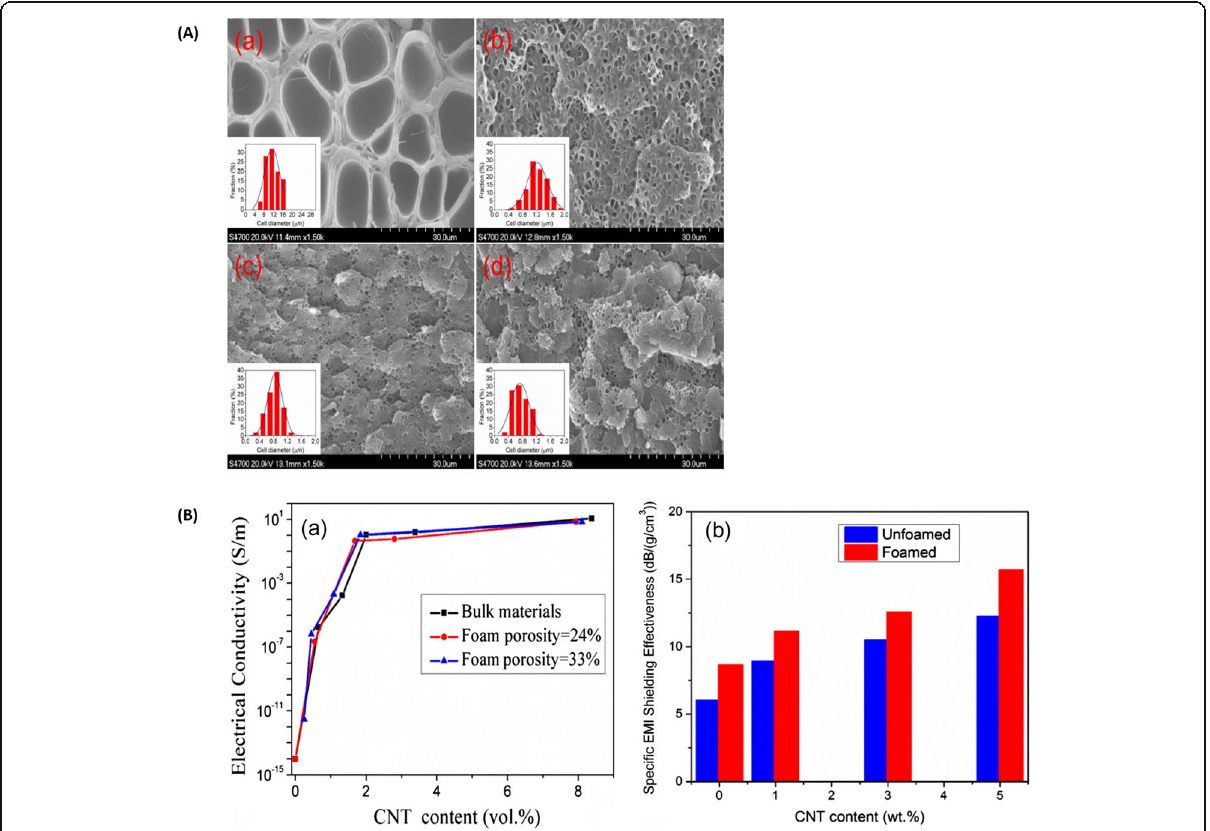
Fig. 20 (A) Scanning electron micrographs of ( a ) neat PC foam, and PC/CNT composite foams with ( b ) 1 wt%, ( c ) 3 wt% and ( d ) 5 wt% of CNTs. The insets are the size distributions of cells in the corresponding foams; ( B ) Electrical conductivity of PC/CNT composites and their foams with different porosities as a function of CNT content, ( b ) specific SE T of PC/CNT composites and their foams at 9.5 GHz. Adapted with permission from Yu et al. [105], copyright 2015